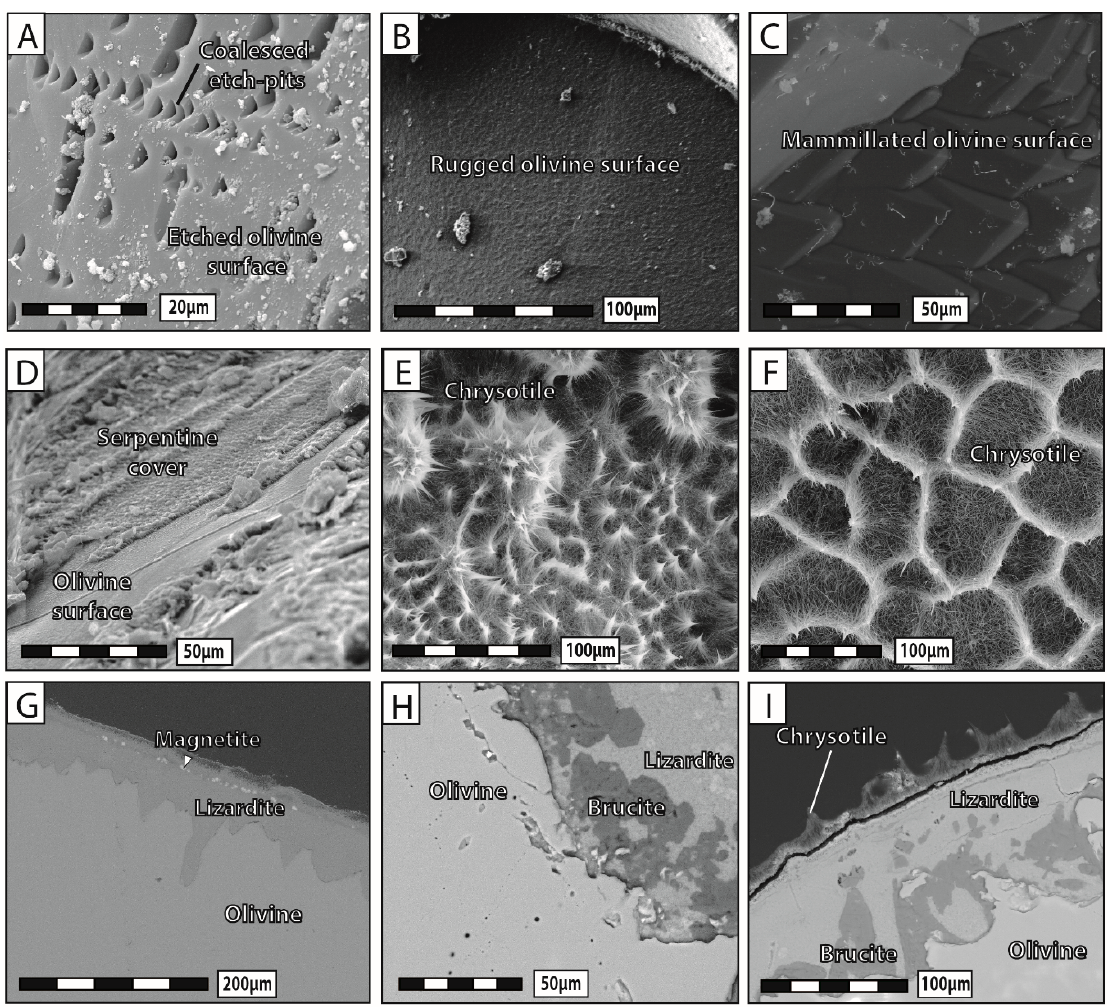
Figure 3. Scanning electron microscope (SEM) images of surface features after reaction in NaOH solution. ( A ) Selective dissolution resulting in closely spaced or coalesced etch pits. ( B ) Rugged and ( C ) mammillated olivine surface. ( D ) Lizardite growing onto fresh olivine. ( E ) Bunches of tepee-like chrysotile bundles. ( F ) Polygonization of the chrysotile cover forming Voronoi tessellation features. ( G ) Cross section through the entire reaction zone showing the chrysotile cover, a thin layer of oxides, and the lizardite alteration margin down to the etched/notched olivine surface, ( H , I ) reaction zones containing lizardite and brucite in contact with healthy olivine. ( A – D ) are for t = 3 months (run # 1), ( E , G ) for t = 6 months (run # 2), and ( F , H , I ) for t = 12 months (run # 3).